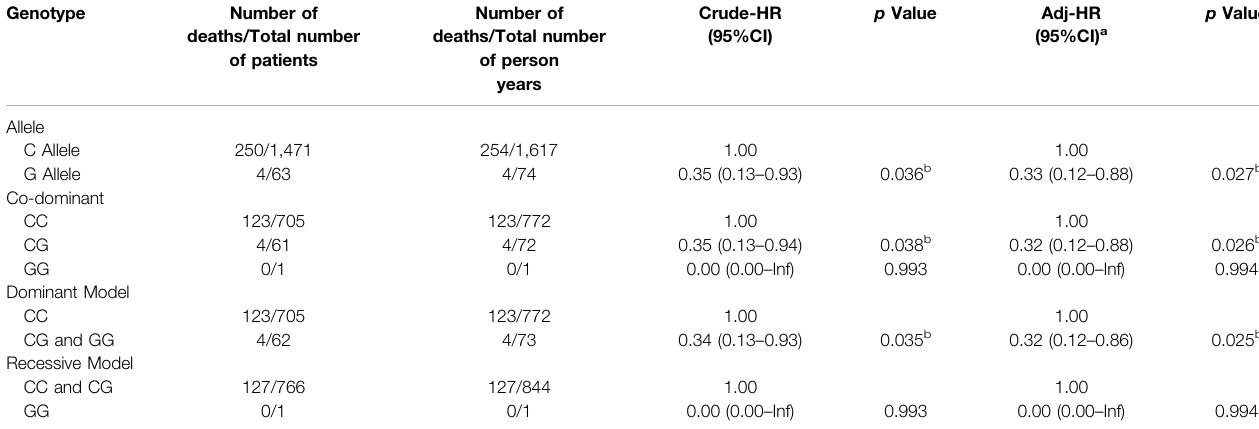
TABLE 2 | Hazard ratio for the association between PPARG Pro12Ala polymorphism in hemodialysis patients and all-cause mortality. Genotype